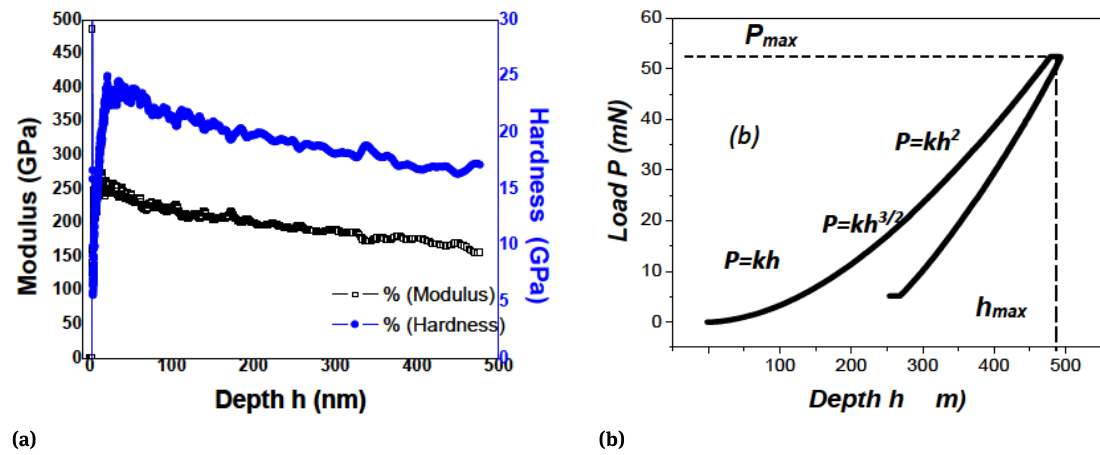
Figure 12: (a) Hardness and modulus variation with indentation depth and the corresponding (b) Load-depth curve for Si-C-N coatings deposited on Silicon substrates [178]